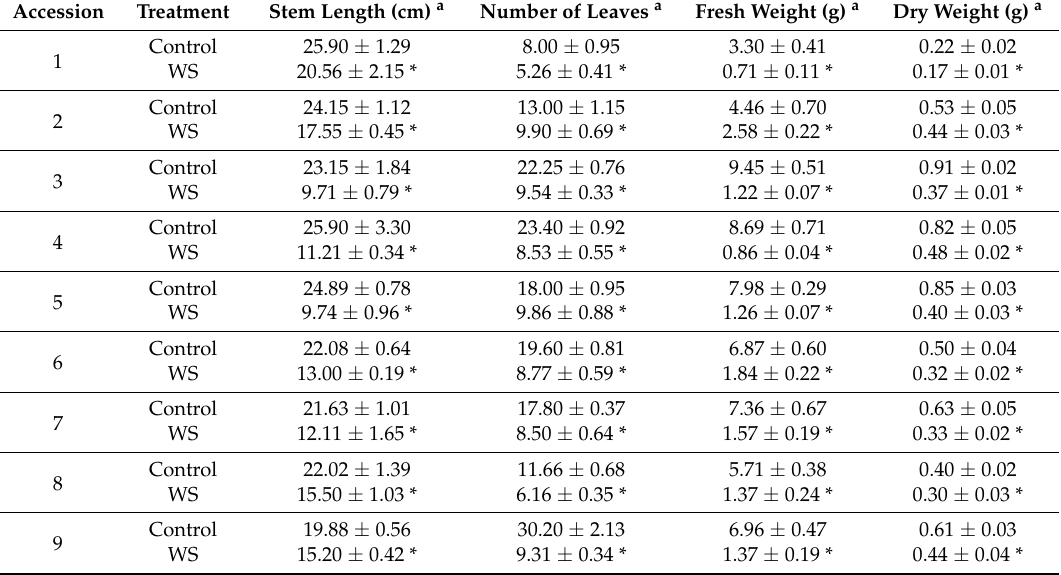
Table 2. Variation (average ± SE) in growth parameters in the nine accessions of the Ardhaoui barley landrace in the control and water stress (WS) treatments after three weeks of initiation of the water stress